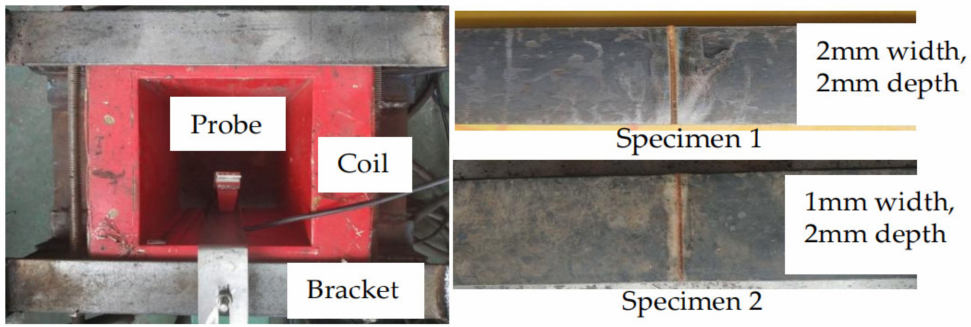
Figure 18. Excitation device and specimens.